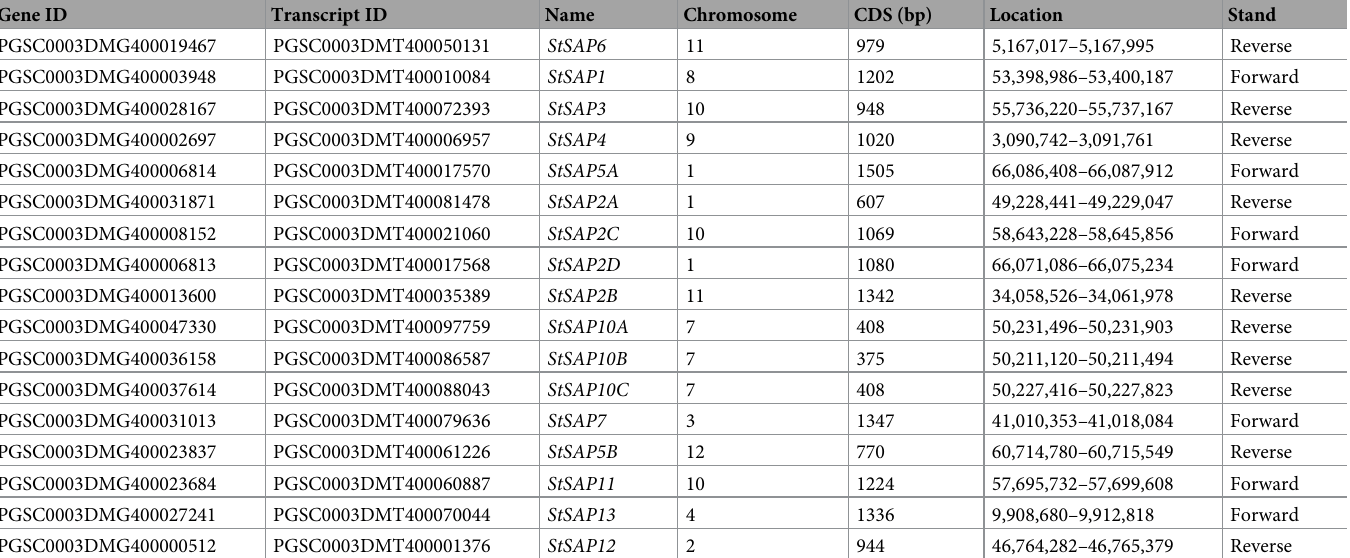
Table 1. Genes coding stress-associated proteins in S . tuberosum .